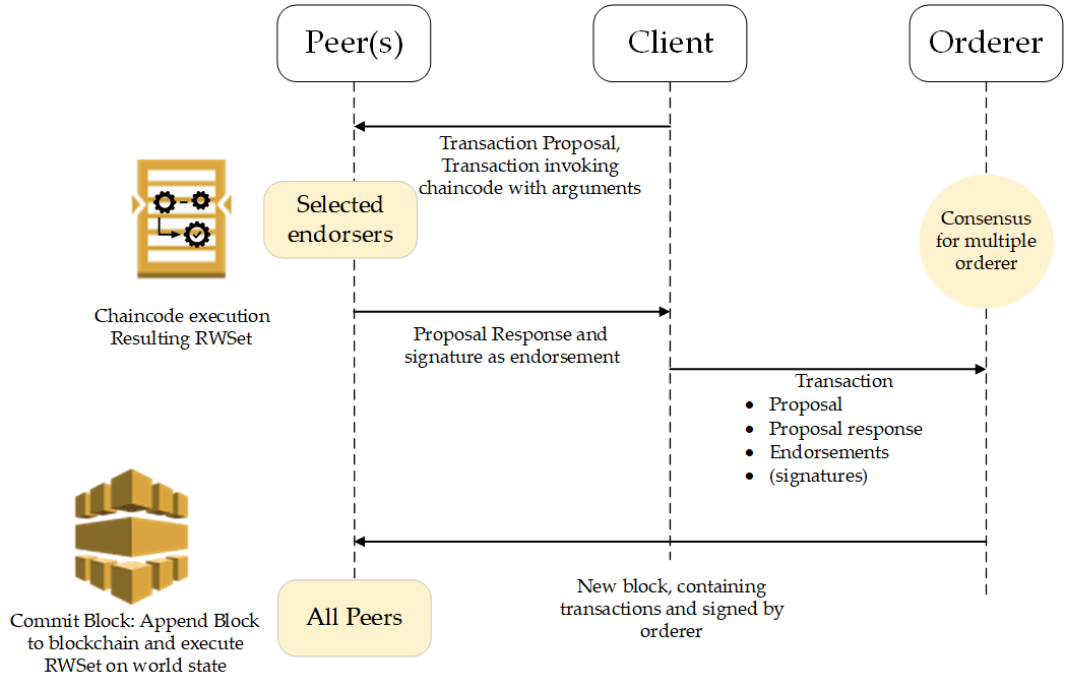
Figure 5. Proposed HLF network transaction